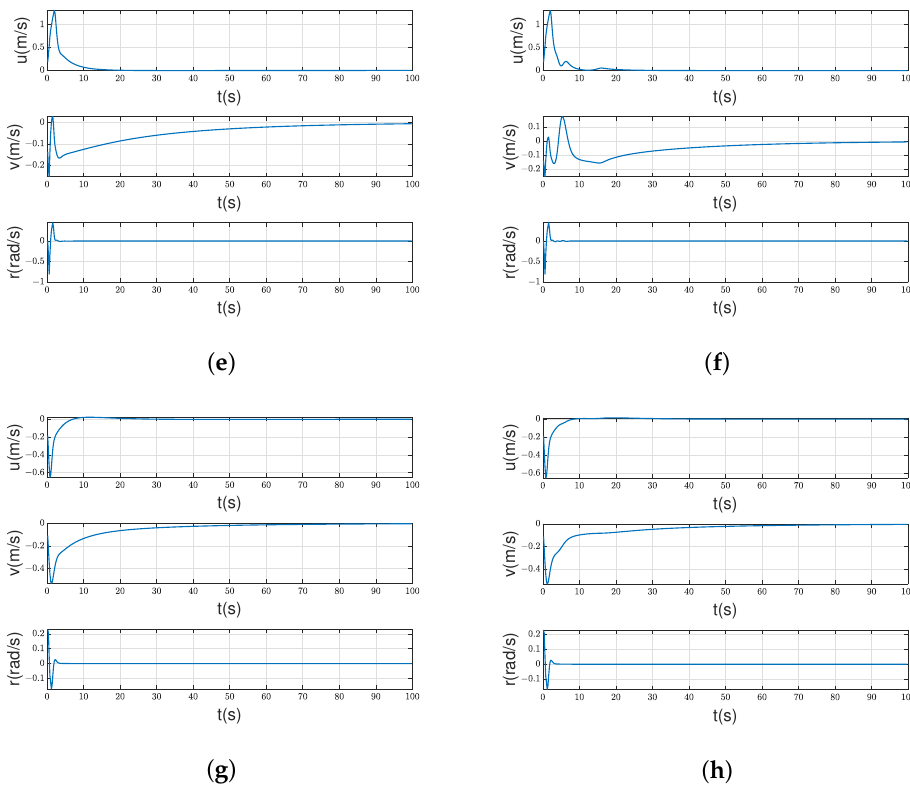
Figure 9. Diagram of speed data during formation of USVs: ( a , c , e , g ) the speed of (USV-A, USV-B, USV-C, USV-D) without artificial potential field; ( b , d , f , h ) the speed of (USV-A, USV-B, USV-C, USV-D) with artificial potential